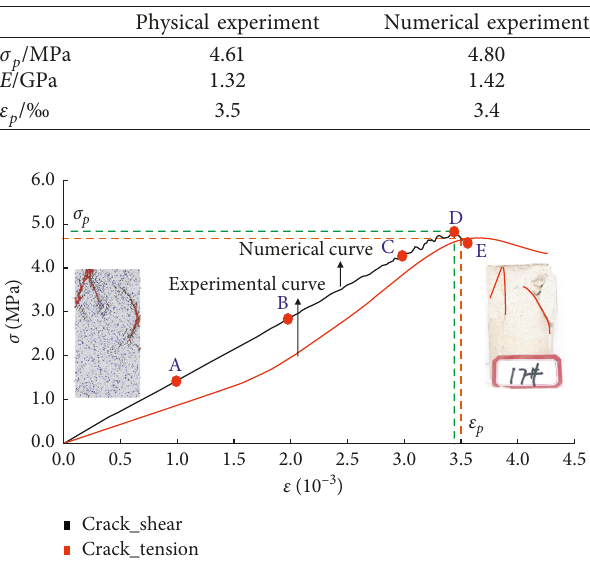
Figure 5: Comparison of stress-strain curves and structural fracturing modes from both physical experiments and numerical